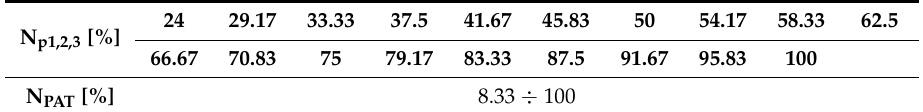
Table 5. Combinations of rotational speeds of the recirculating pumps and of the PAT for performance measurements using the dynamic